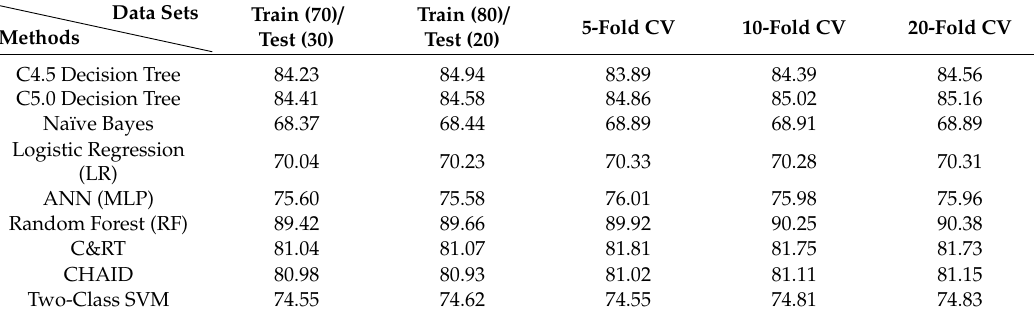
Table 5. Prediction of stroke by machine learning algorithm after normalization